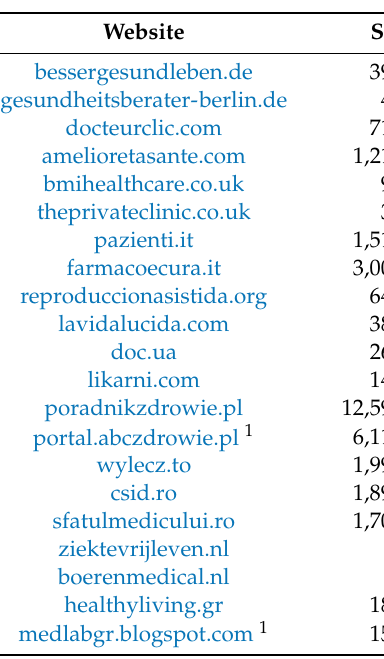
Table 2. Visibility data of 21 websites considered as decreased by Google medical